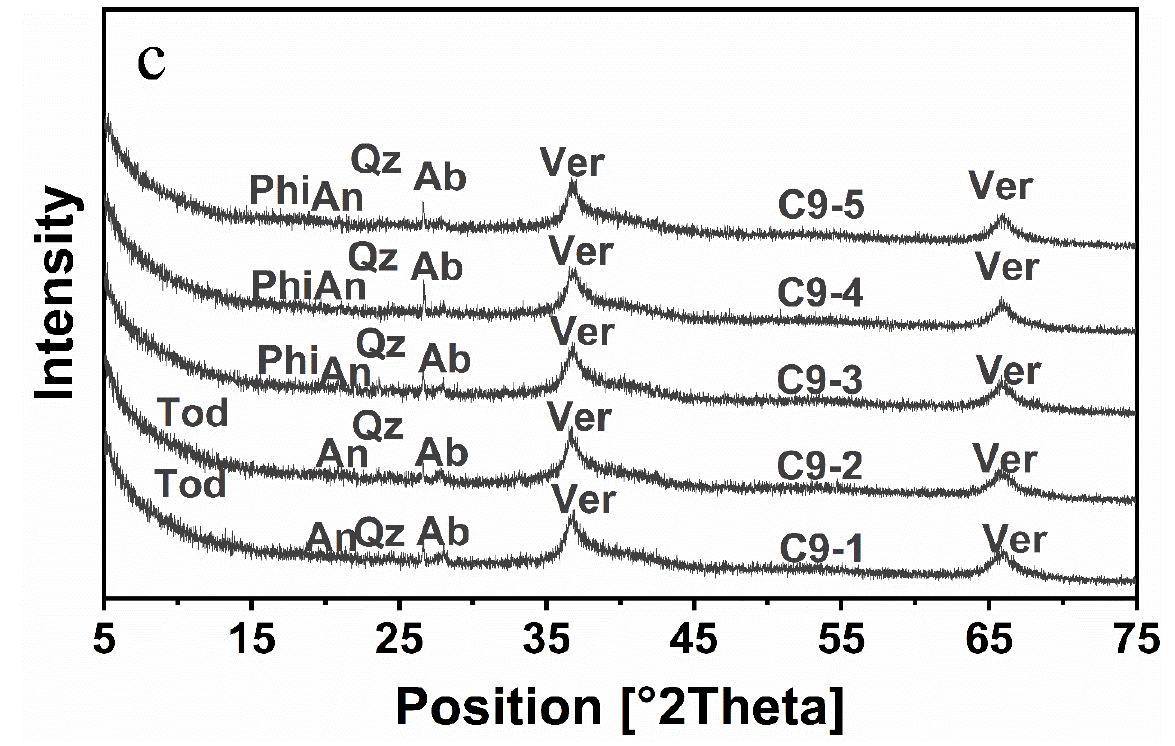
Figure 5. ( a – c ) The XRD patterns for ferromanganese deposits on the slope of Caiwei Guyot; Ver = Fe-vernadite, Ab = Al, Tod = todorokite, Qz = Quartz, Ab= Albite, Anorthite = An, Phi = Phillipsite.